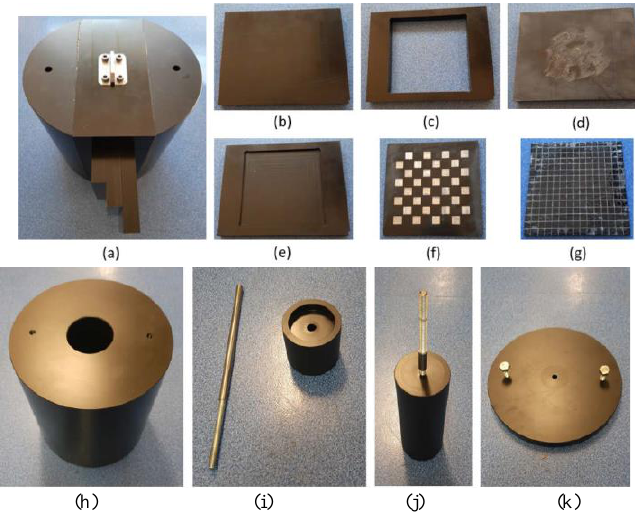
Fig. 1. Components of phantom 1 (a-g) and phantom 2 (h-k) used for calibration of the X-Ray imaging system at the MELT